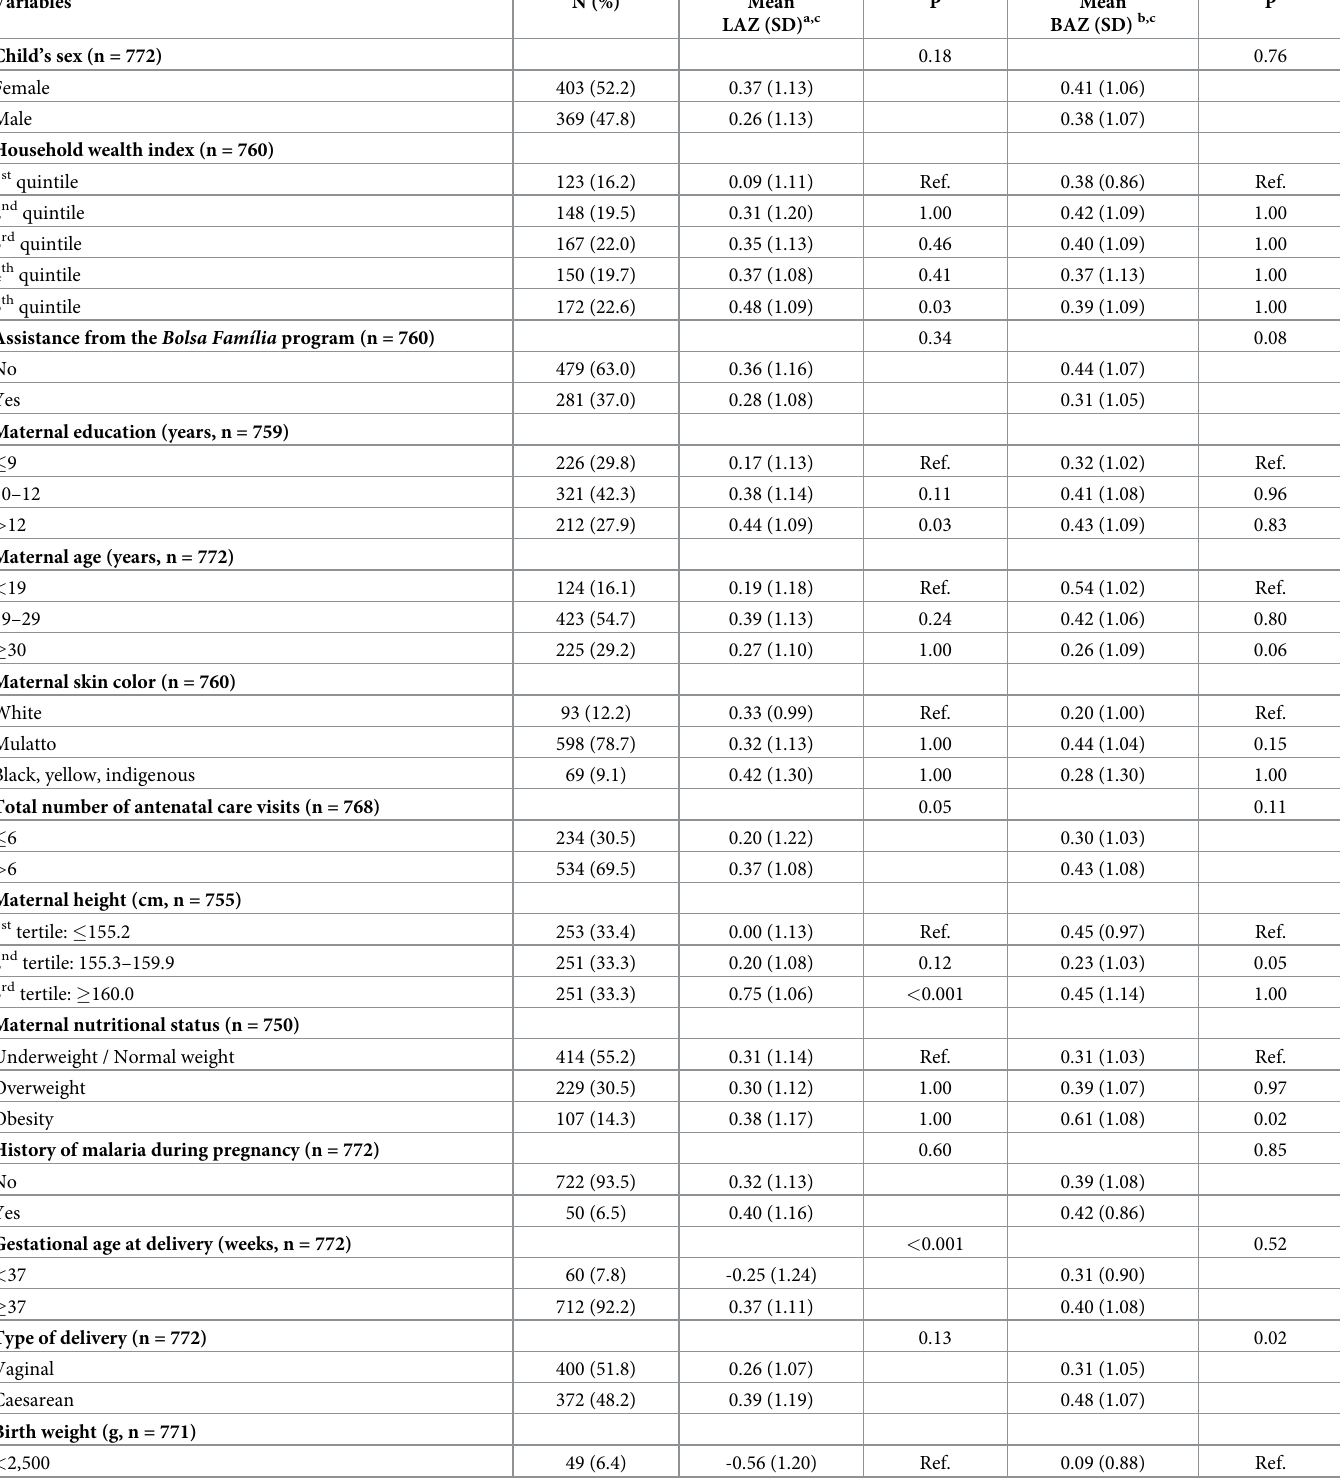
Table 1. Mean length-for-age Z score (LAZ) and BMI-for-age Z score (BAZ) at 10–15 months of age according to socioeconomic, maternal and child characteristics, MINA-Brazil Study, Cruzeiro do Sul, Acre, Brazil.